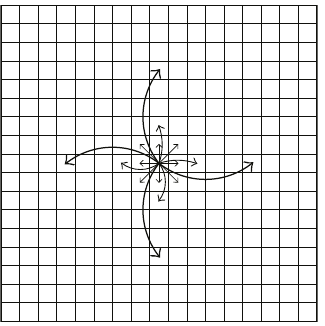
Figure 2: Cell neighborhood connections. Because the connections are bidirectional, the number of actual wires per cell is only 8.